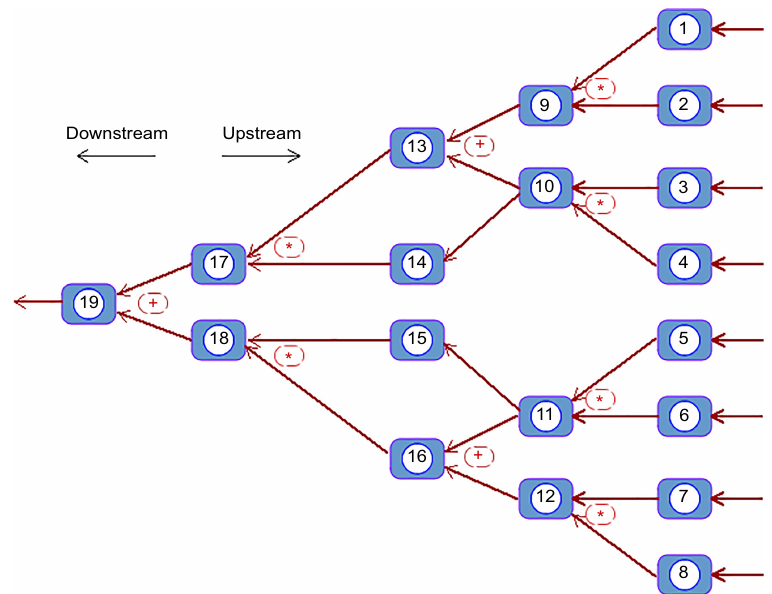
Figure 7. Example of